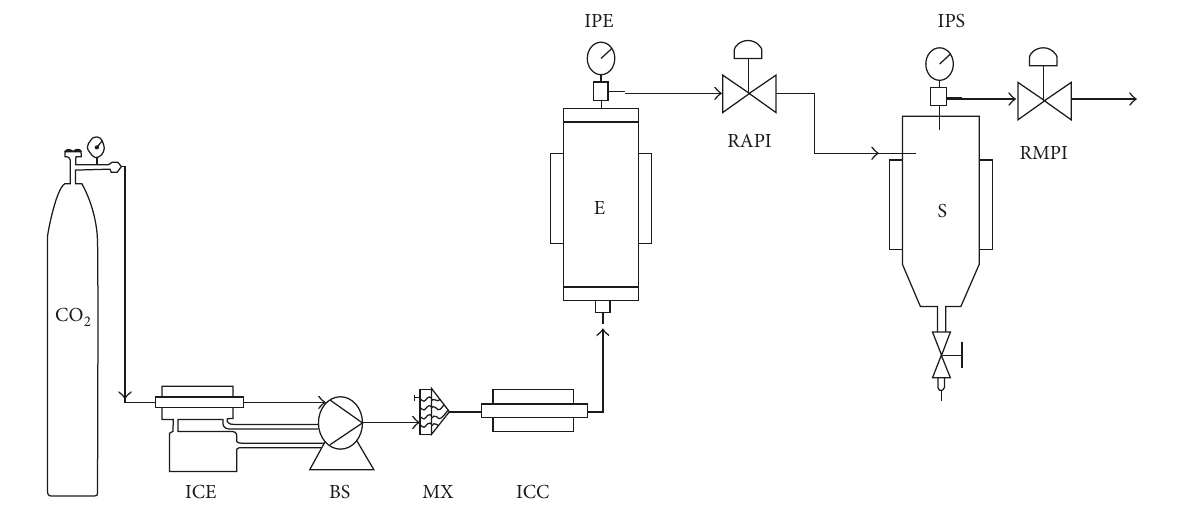
Figure 1: Schematic representation of the SCFE plant